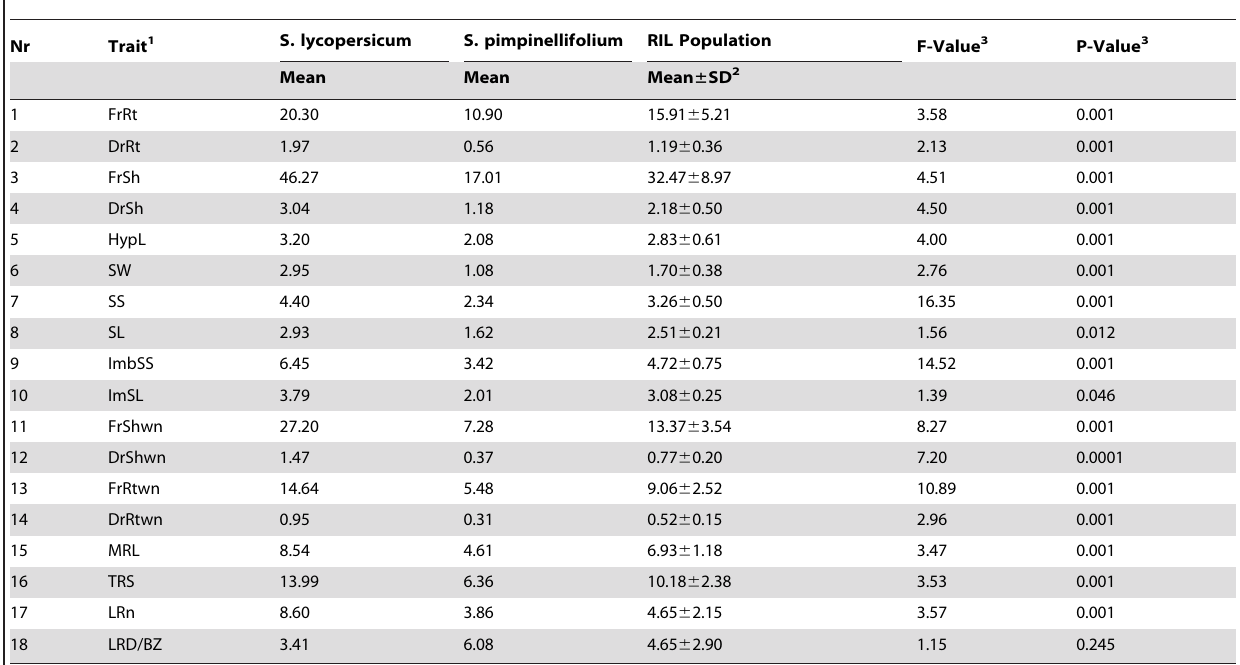
Table 1. Phenotypic analysis of seed and seedling related vigor traits of a S. lycopersicum and S. pimpinellifolium RIL population and its two parents.